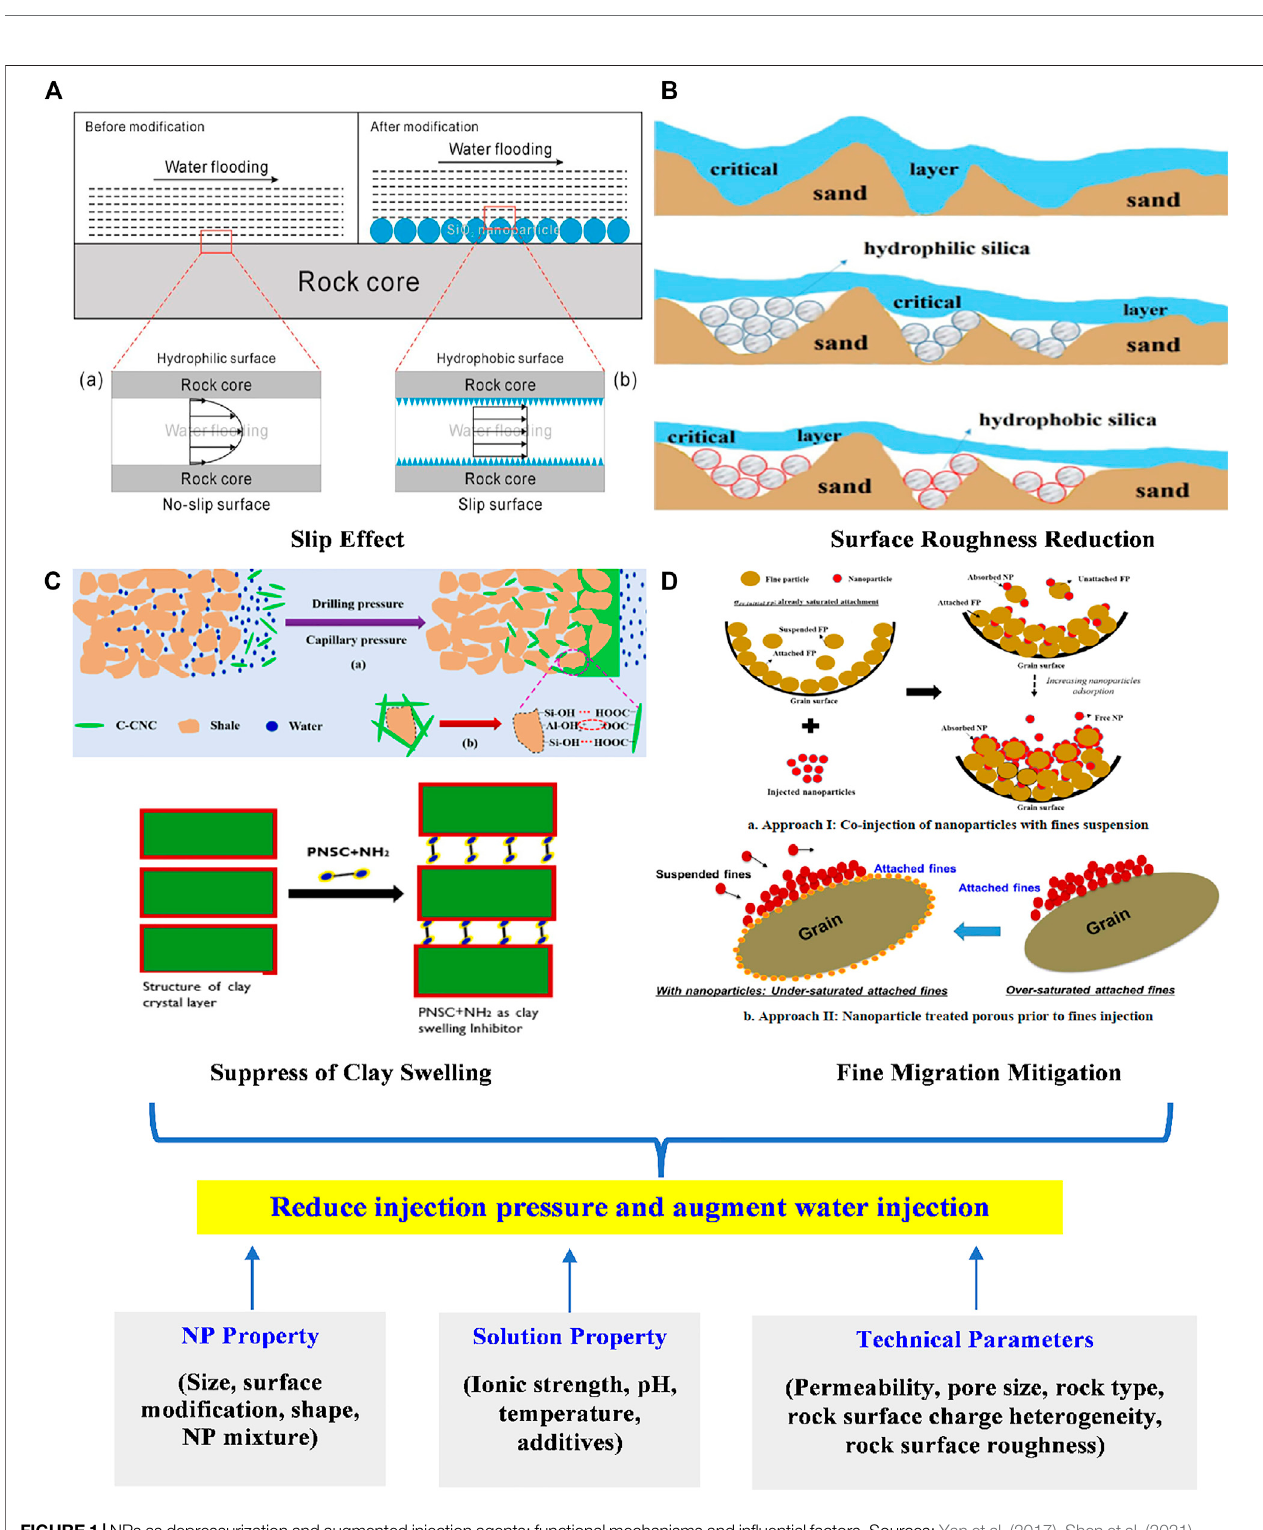
FIGURE1| NPs asdepressurization and augmented injection agents: functional mechanisms and in fl uential factors.Sources: Yan et al. (2017),Shen et al. (2021), Oseh et al. (2020), Zhao et al. (2017), Zhao et al. (2021), Yuan et al. (2018). (A) Slip effect, (B) Surface roughness reduction, (C) Suppress of clay swelling, (D) Fine migration